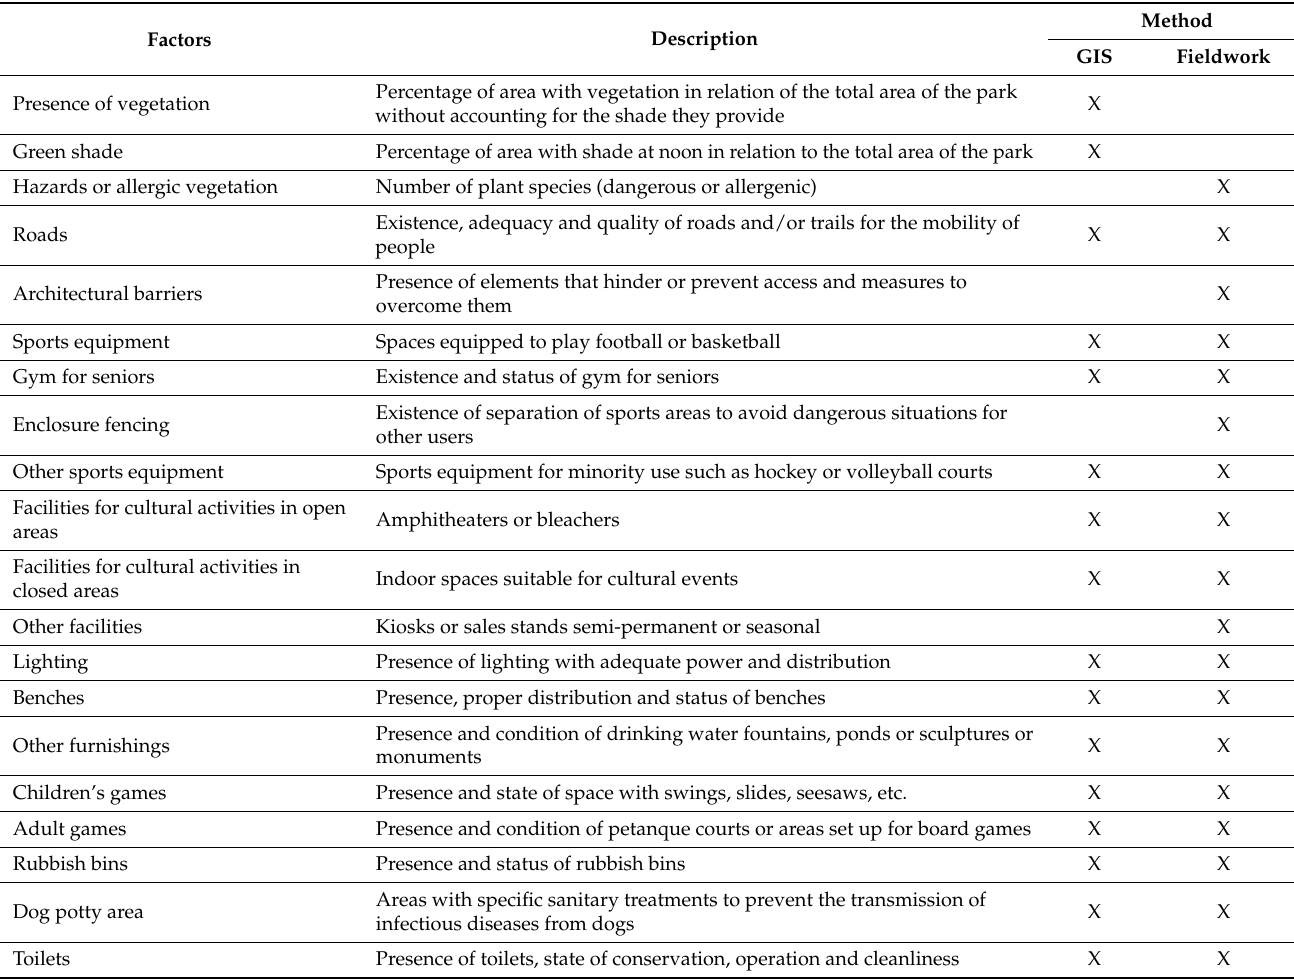
Table 1. Factor name, description and methodology used to obtain them. Selection based on Canosa, S á ez, Sanabria and Zavala (2003) and Rivera (2015).